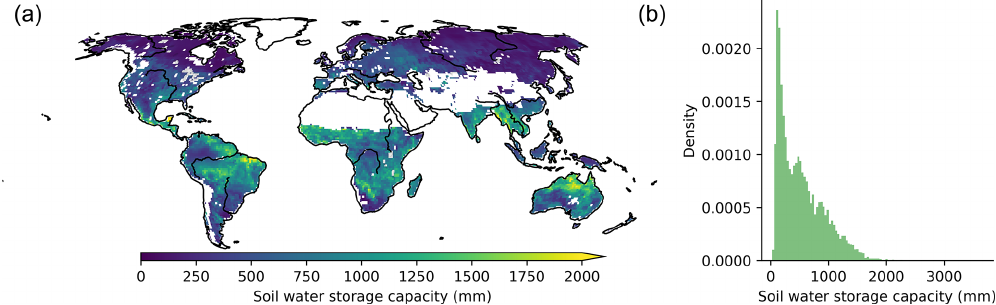
Figure B16. Spatial distribution (a) and histogram (b) of the soil water storage capacity of SINDBAD shown as the sum of the capacity of two soil layers.